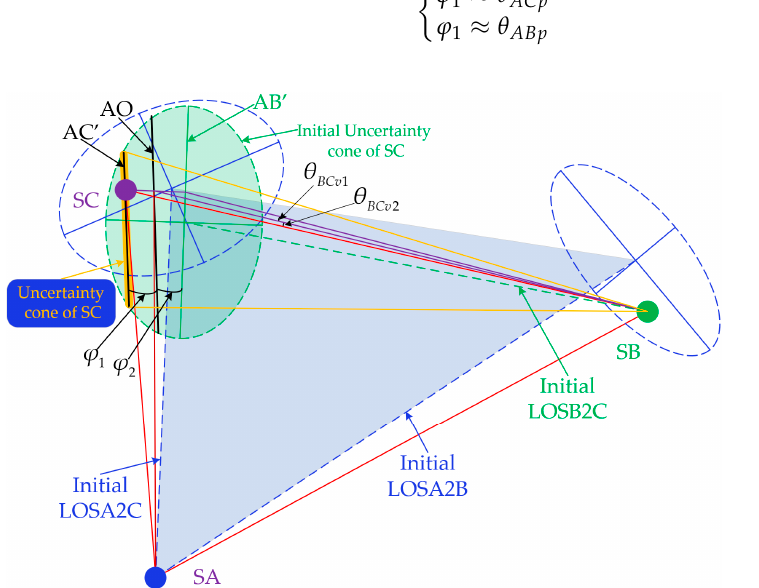
Figure 6. Schematic diagram of the third two-way laser link. Where the initial LOSB2C denotes the initial line of sight of the T2 of SB towards SC, segment AC’ denotes the projection of the actual direction between SA and SC on the circular plane area of the initial uncertainty cone of SC, while segments AO and AB’ denote the projection of the initial LOSA2C and the actual direction between SA and SC, respectively, ϕ 1 denotes the angle between AC’ and AO, and ϕ 2 denotes the angle between AO and AB’.